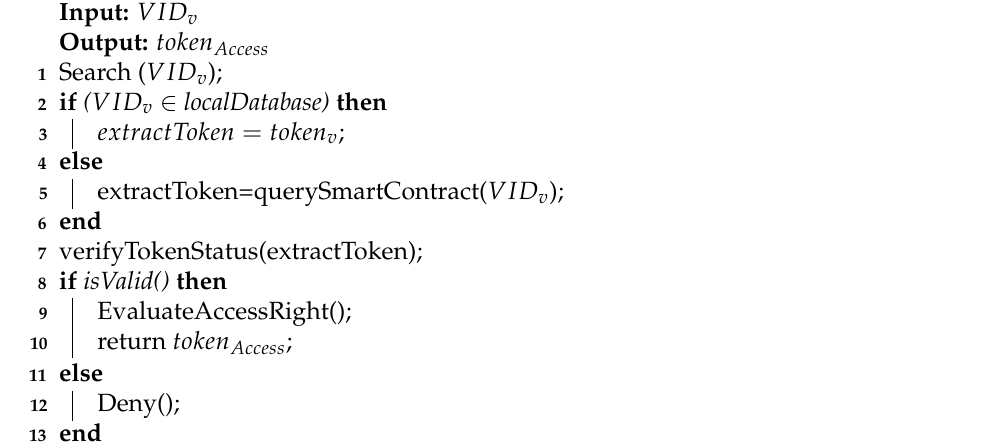
Algorithm 2: Authorise Access (Function